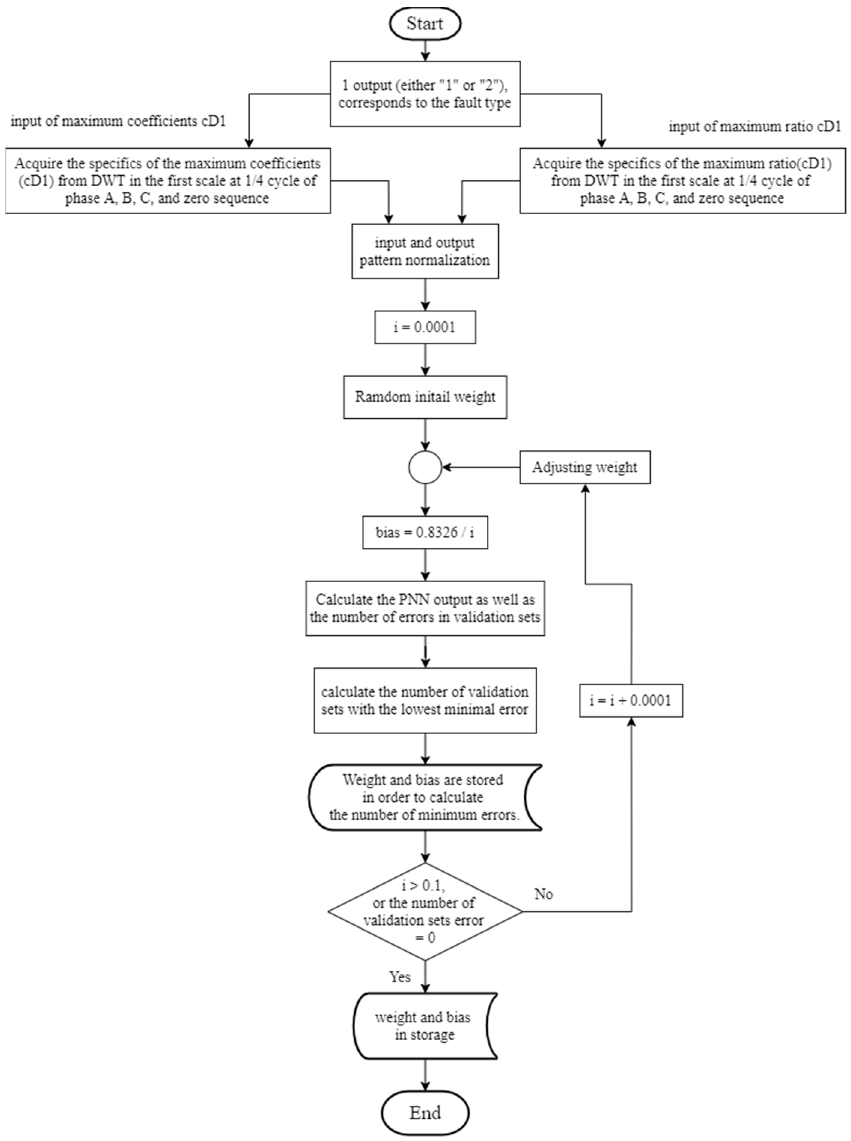
Figure 11. Flowchart for the training process. Table 3. Results of the training procedure in comparison.